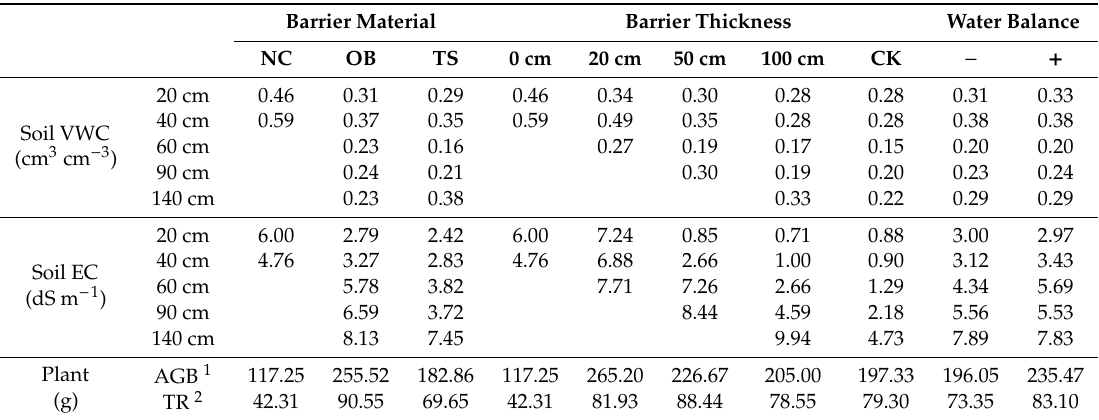
Table 3. Statistical results of the treatment e ff ects on soil water, EC and plant after 3 growing seasons. Barrier Material Barrier Thickness Water